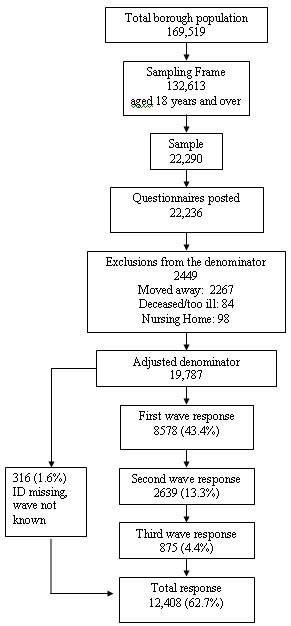
Flow chart of the survey.